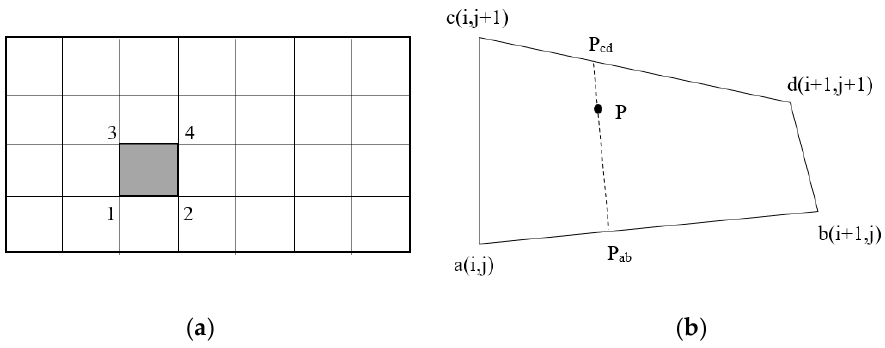
Figure 4. ( a ) Matrix portion generated in a projector. ( b ) Matrix cell projected on the